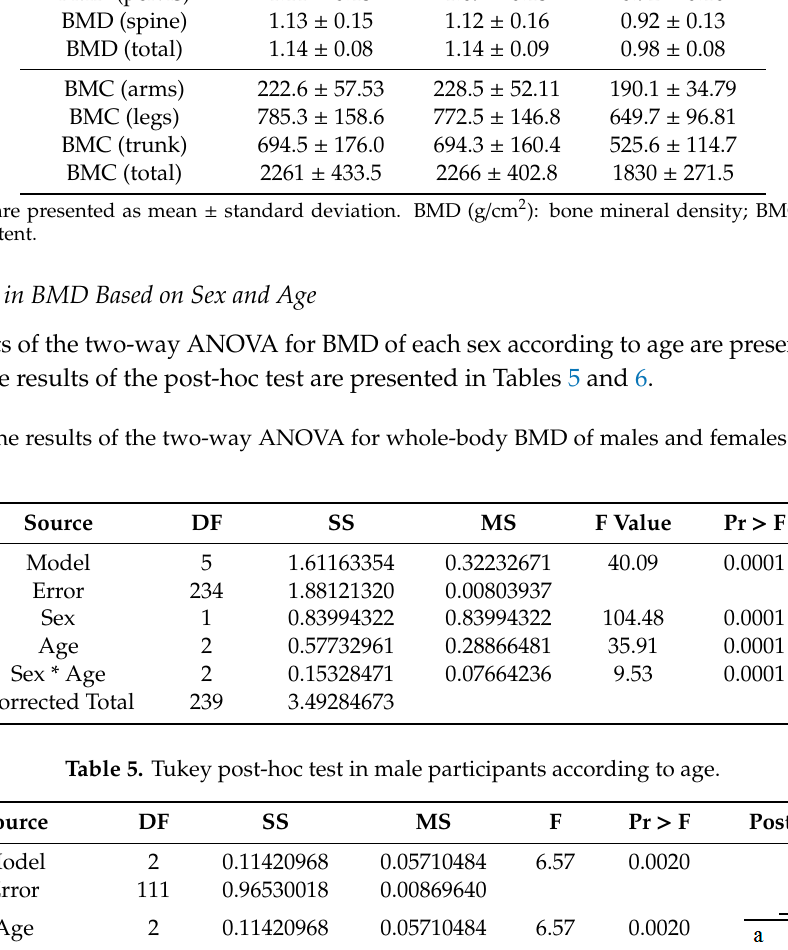
Table 6. Tukey post-hoc analysis in female participants according to age.